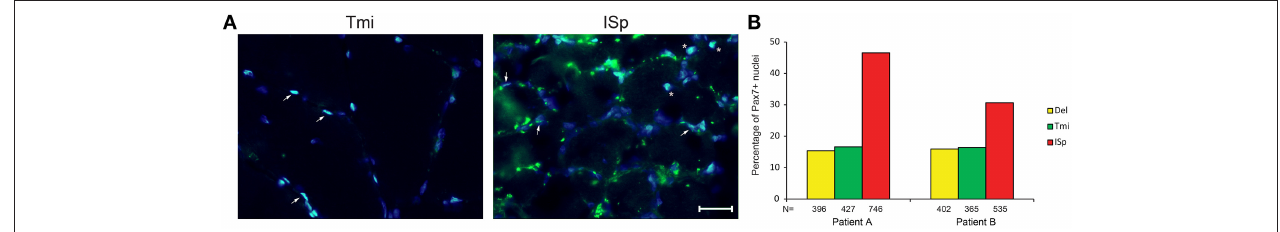
FIGURE 4 | Satellite cells in torn and non-torn shoulder muscles. (A) Representative images of Pax7 immunostaining (green) in non-torn RC muscle teres minor (Tmi) and torn infraspinatus (ISp). Nuclei were counter-stained with DAPI (blue). Pax7-positive nuclei have an overlay of blue and green. Examples of Pax7-positive myonuclei are marked with arrowheads. Examples of Pax7-positive nuclei not in myonuclei are marked with asterisks. Scale bar represents 25 µ m. (B) Bar charts for the quantification of Pax7-positive nuclei in deltoid, teres minor and infraspinatus sections of two patients. N represents the number of total nuclei analyzed for each muscle in 11